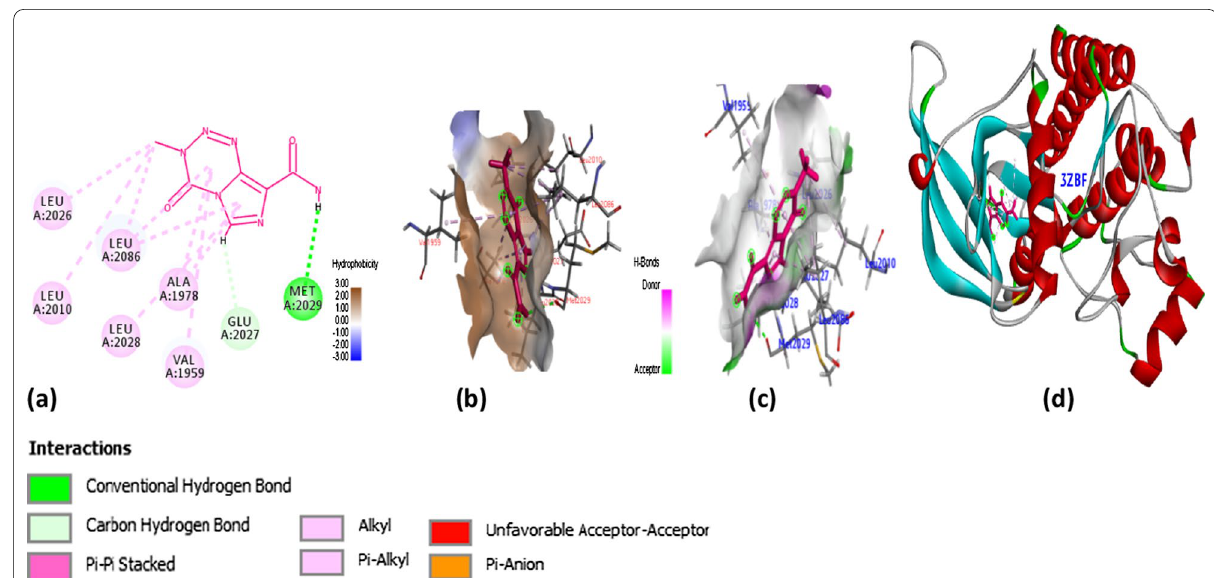
Fig. 10 2D and 3D interaction images of drug Temozolomide at the binding sites of protein C-ROS1 (3ZBF: PDB (P4))